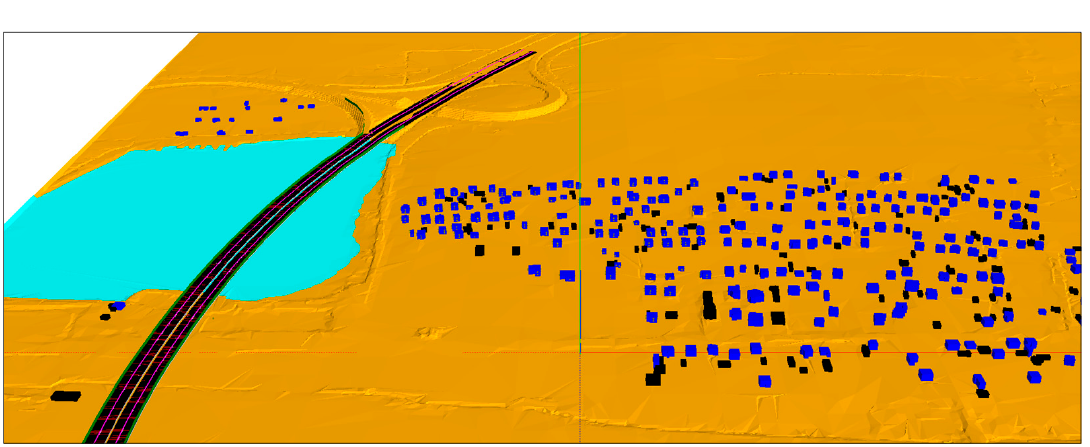
Figure 4. View of the geometric model used for the acoustic modeling.